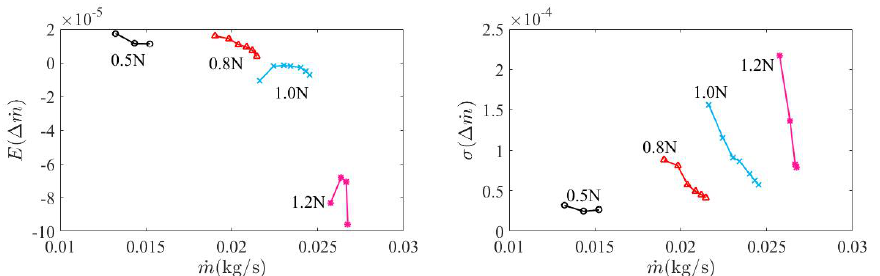
Figure 22. Uncertainty statistics of mass flow rate.